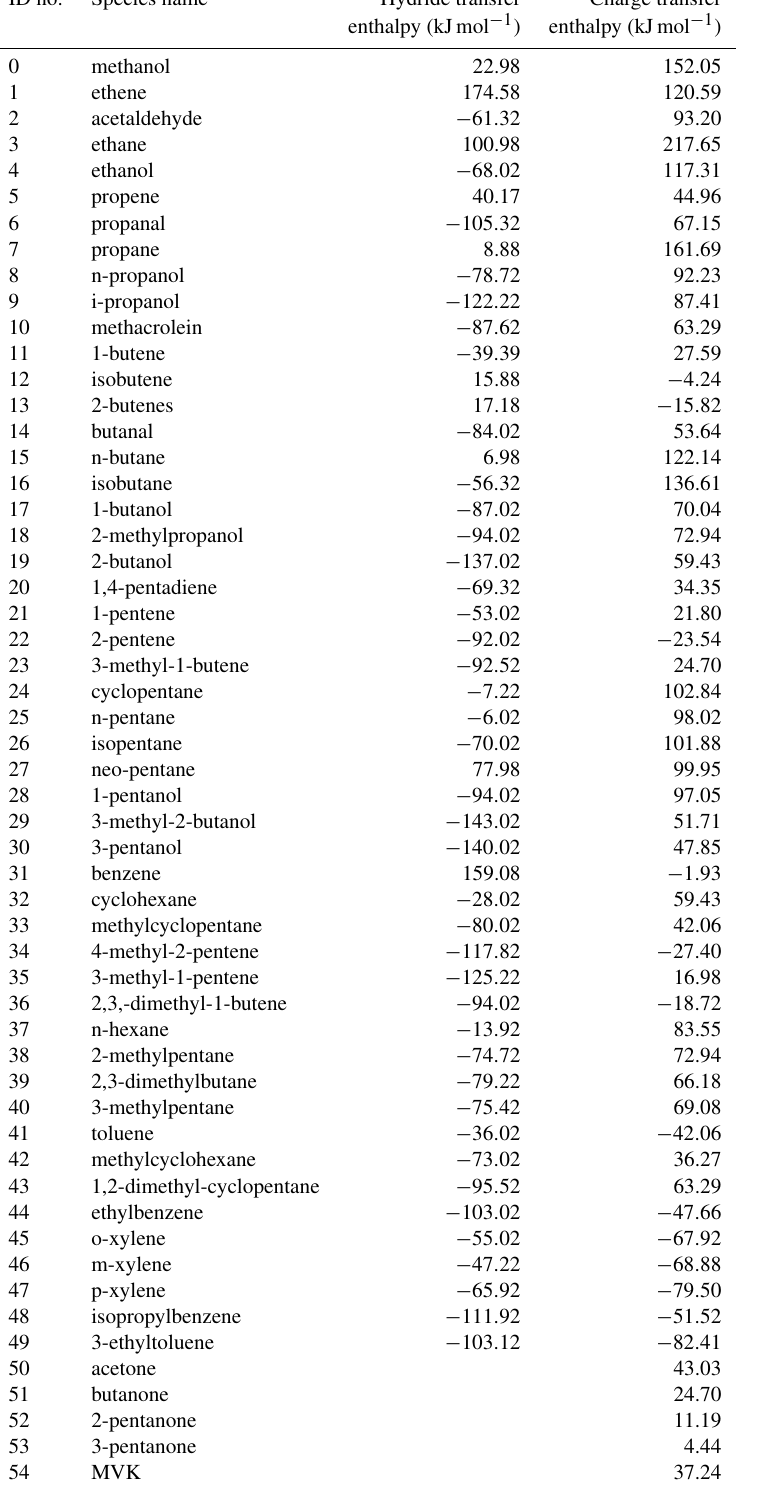
Table 1. VOC species in Fig. 4 and their charge transfer and hydride transfer reaction enthalpies. ID